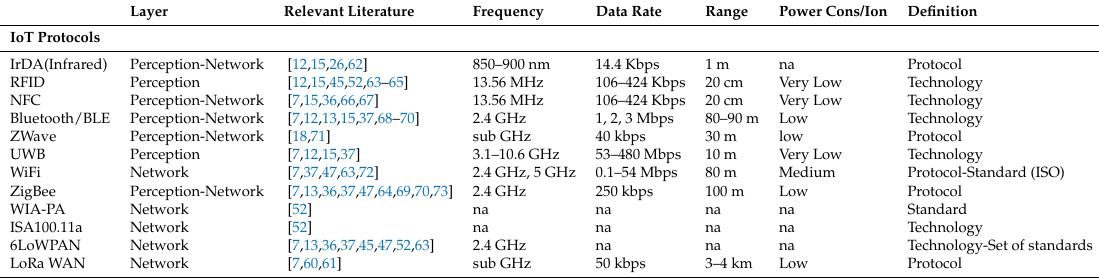
Table 2. A summary of Perception and Network layer IoMT Communication